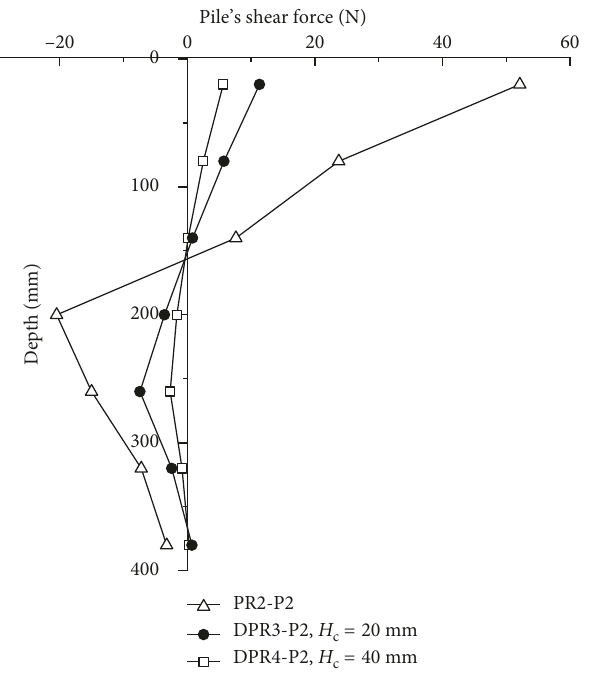
Figure 9: Influence of the interposed layer on responses of the pile shear force under a 300N horizontal force.